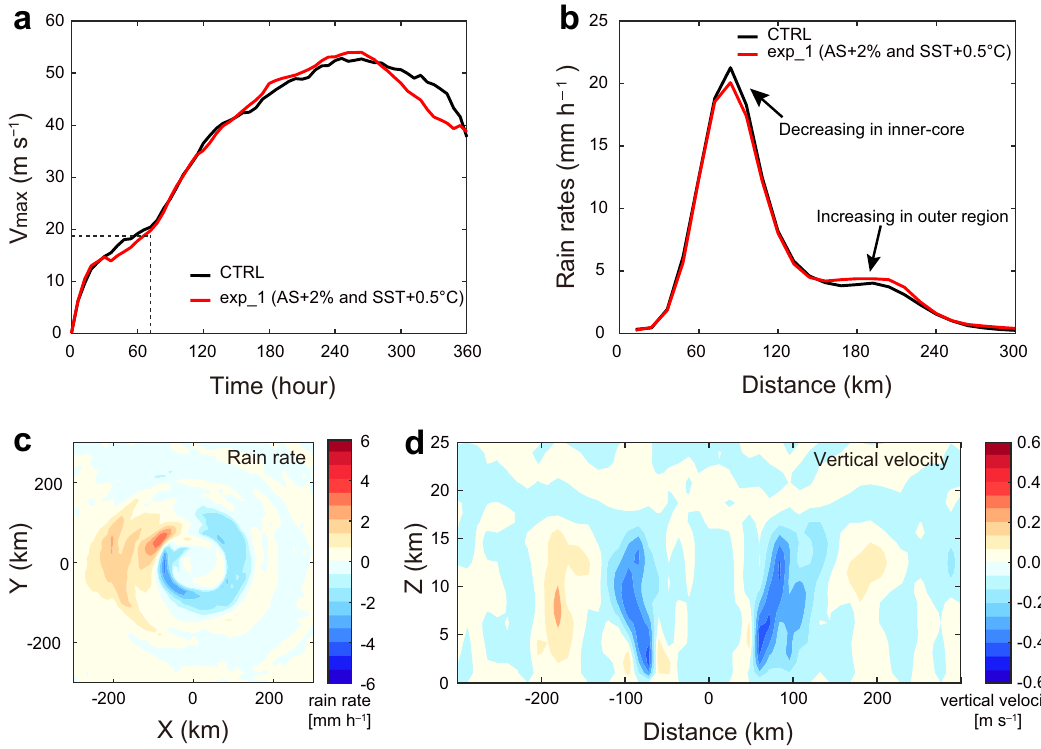
Fig. 5 Tropical cyclone (TC) intensity, rain rate, and vertical velocity of TC in the numerical experiments. CTRL (black line): the default Jordan ’ s sounding and 28 °C sea surface temperature (SST), exp_1 (red line): the atmospheric stability increases by 2% and SST increases by 0.5 °C based on CTRL. a The running mean of 5-points of the maximum wind speed ( V max ), unit: m s − 1 . b The radial rain rate, unit: mm h − 1 . c The difference in rain rate (exp_1 – CTRL), unit: mm h − 1 , and d The difference in vertical velocity (exp_1 – CTRL) in a vertical east-west cross-section across the TC center, unit: m s – 1 . Details of the experimental design are described in “ Methods ”